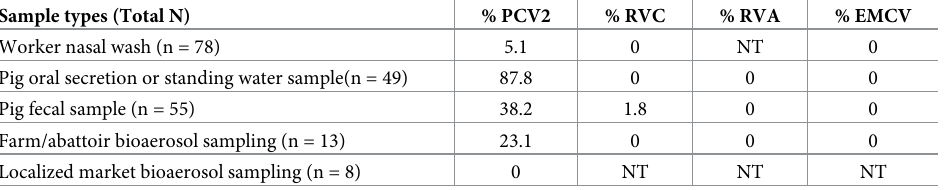
Table 1. Molecular positivity for swine viruses detected via rPCR or rRT-PCR in samples collected from animal environments in Sarawak, Malaysia in June and July of 2017.